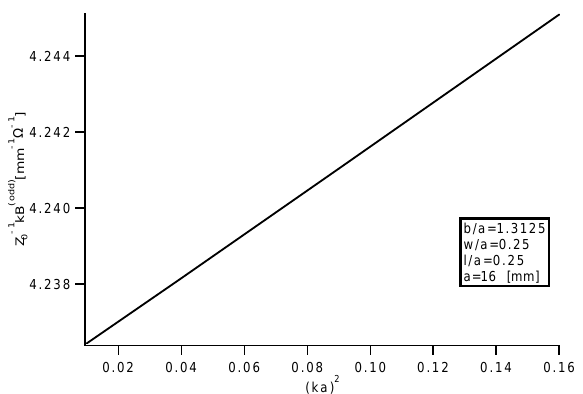
FIG. 1. Electric part of the imaginary admittance at low frequencies.